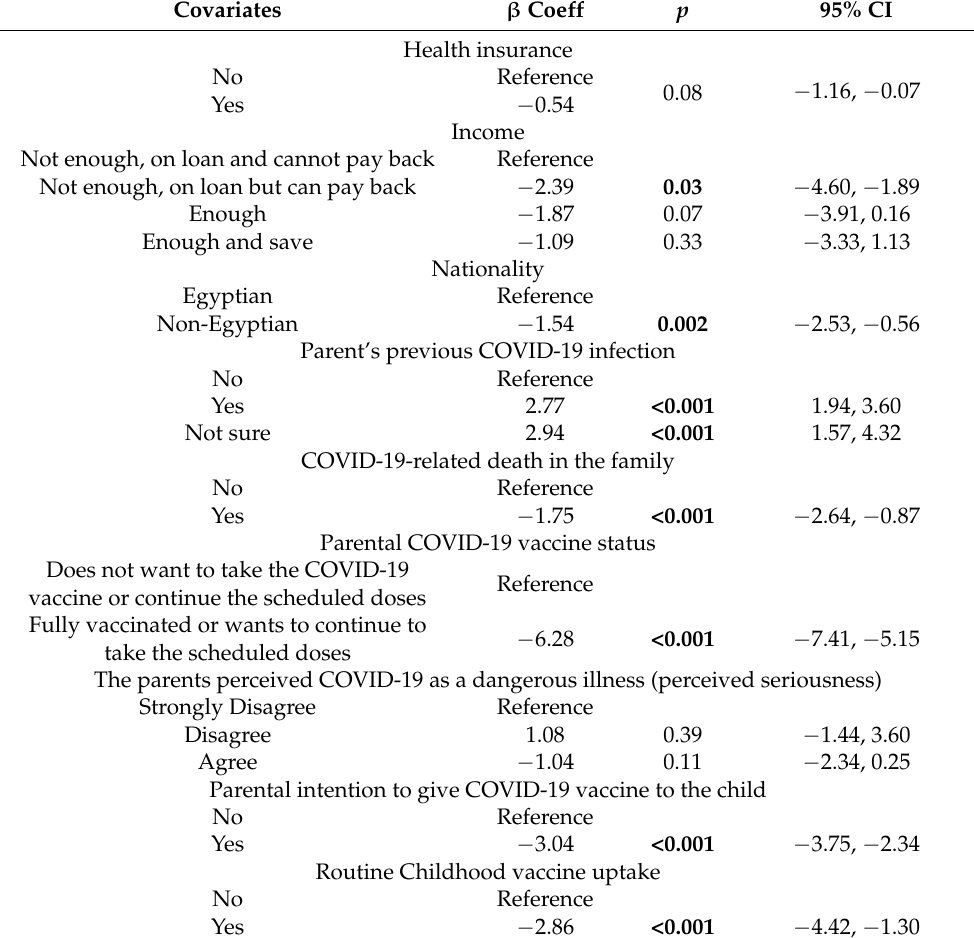
Table 5. Multilinear regression between the PACV score and different covariates ( n = 321). Covariates β Coeff